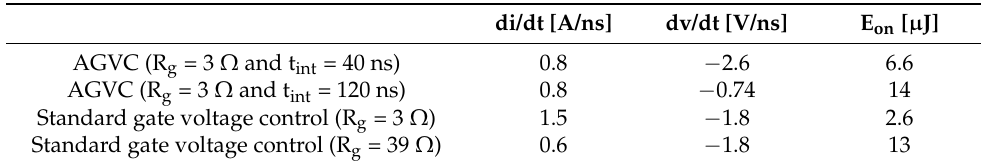
Table 1. Comparison of energy losses using AGCV and standard gate control with load current without saturation (I d = 5 A).